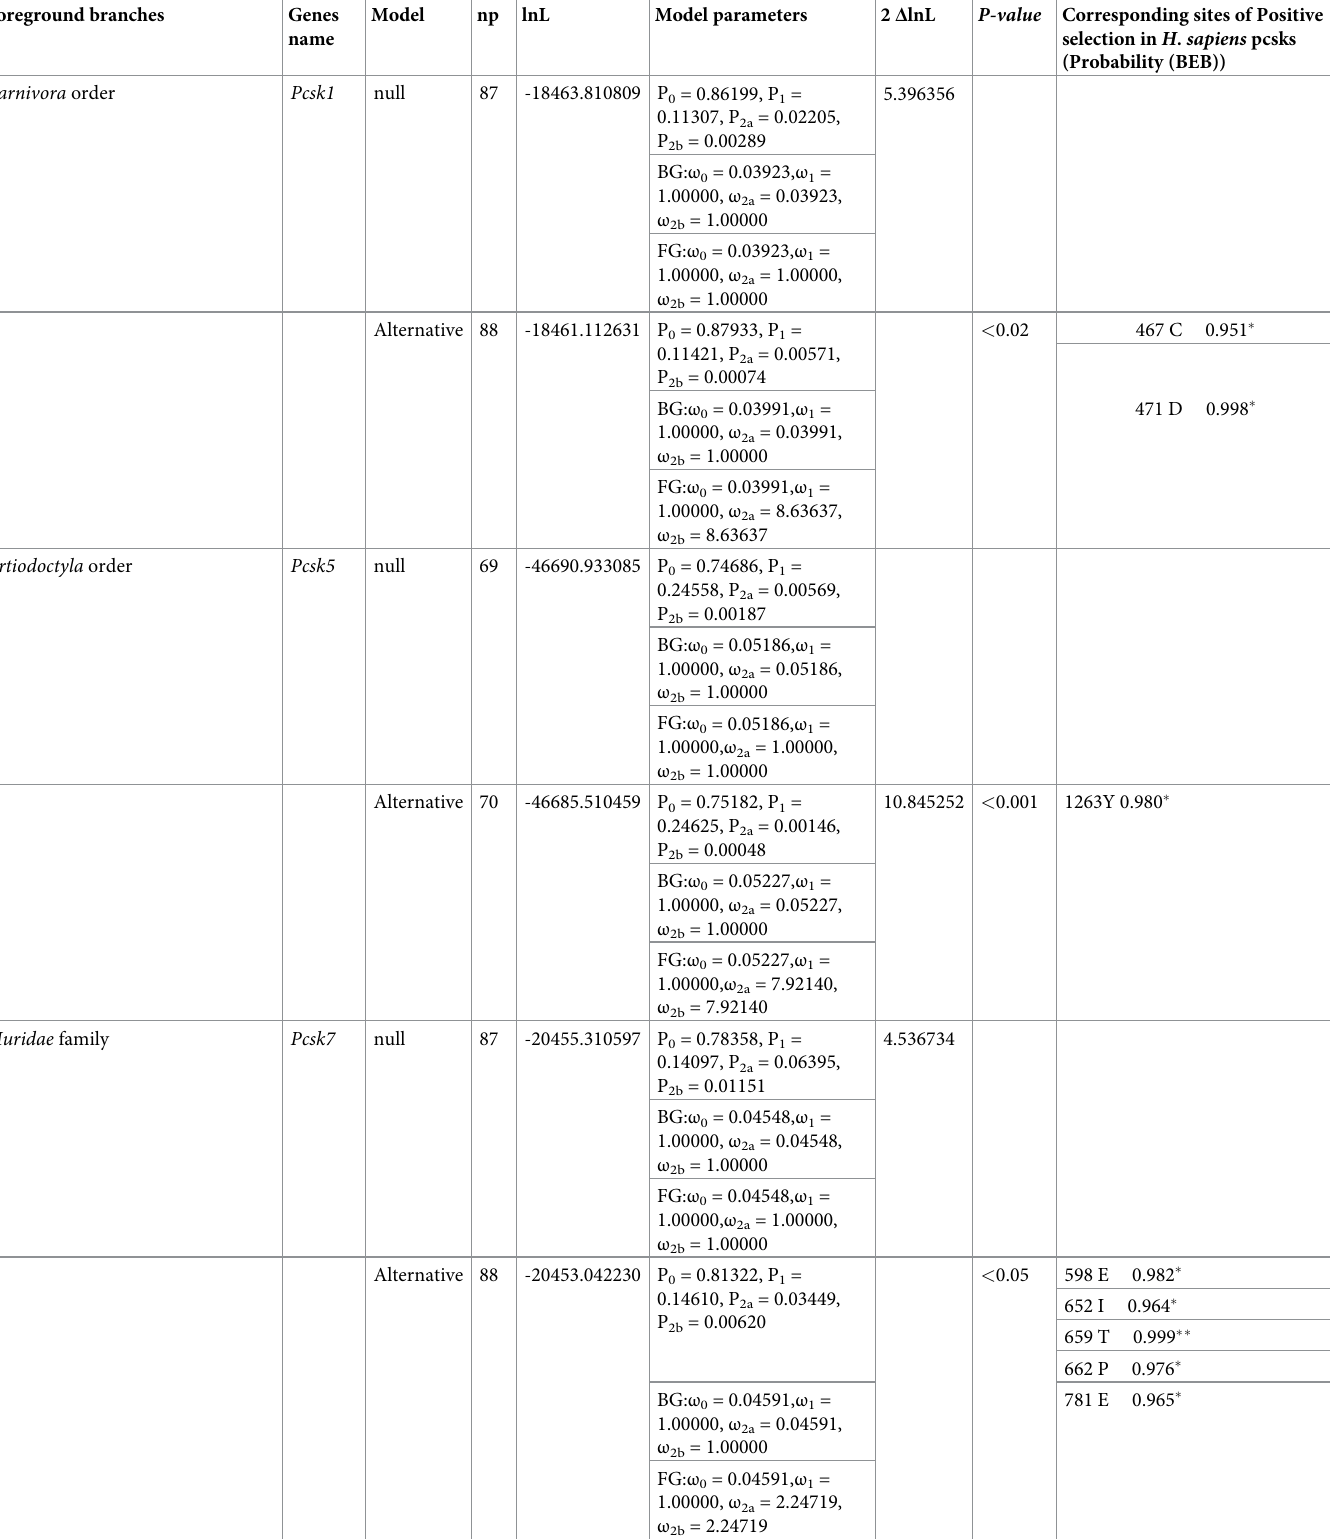
Table 3. Parameter estimates for pcsk1, pcsk5, pcsk7 and pcsk9 branch site